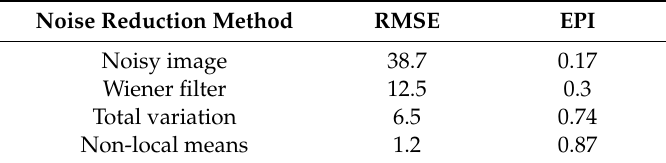
Figure 4. Examples of the simulation study: original, noise component, Wiener filter, total variation, and proposed non-local means denoising algorithm, acquired with our simulation modeling and these magnified images in a selected region. Table 2. The results of root-mean-square error (RMSE) and edge preservation index (EPI) with respect to noise reduction